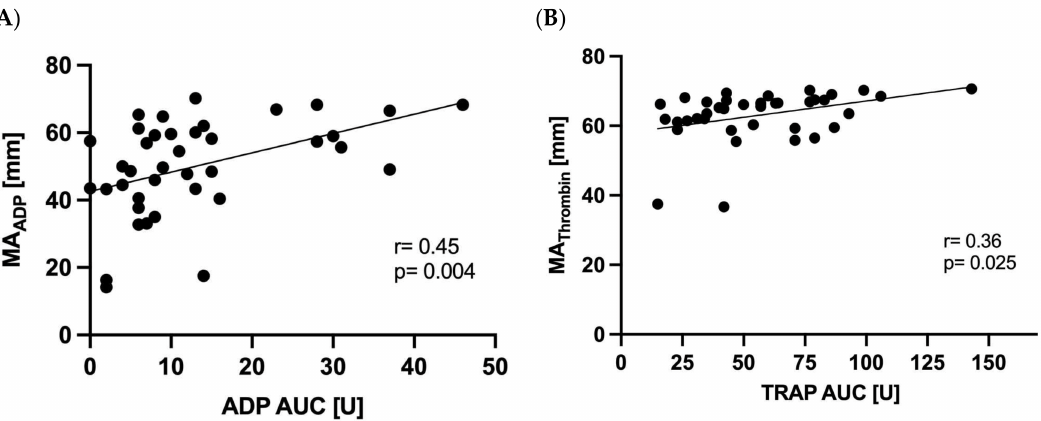
Figure 3. Correlation of multiple electrode aggregometry with thrombelastography. ADP AUC with MA ADP ( A ) and TRAP AUC with MA Thrombin ( B ).